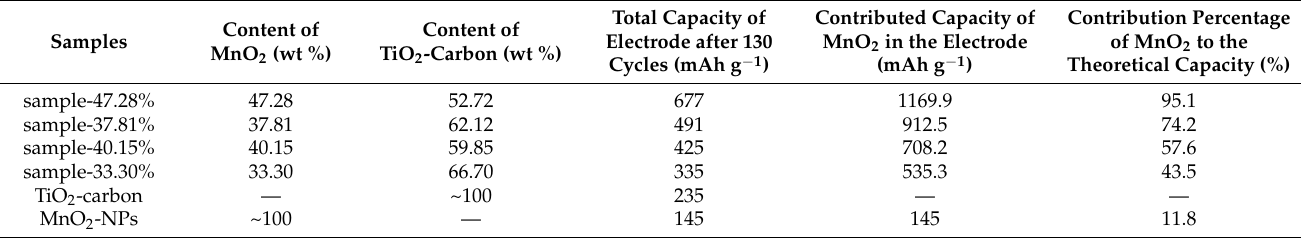
Table 2. Comparisons of the contributed capacities and percentages of MnO 2 to the theoretical capacities in the MnO 2 -TiO 2 - carbon-47.28%, 37.81%, (sample-47.28%, -37.81%), and MnO 2 -carbon-40.15%, 33.30% (sample-40.15%, -33.30%), TiO 2 -carbon and MnO 2 -NPs electrodes.